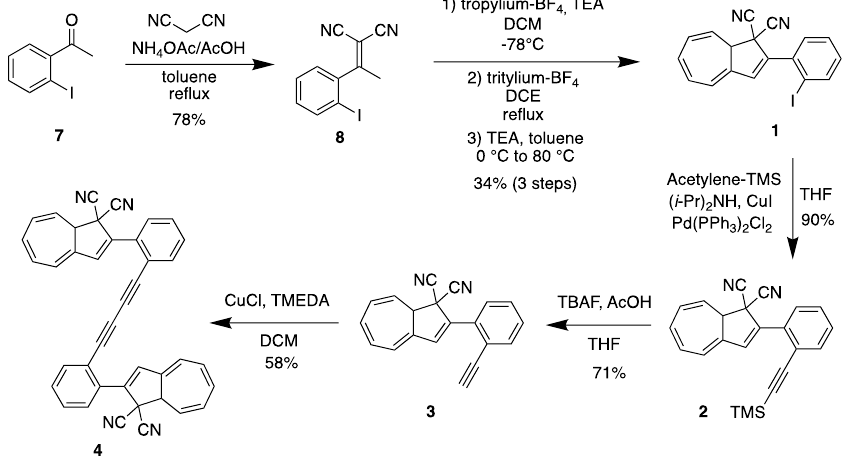
Figure 3. ortho -Phenyl-substituted DHAs and ortho -, meta- and para- linked DHA